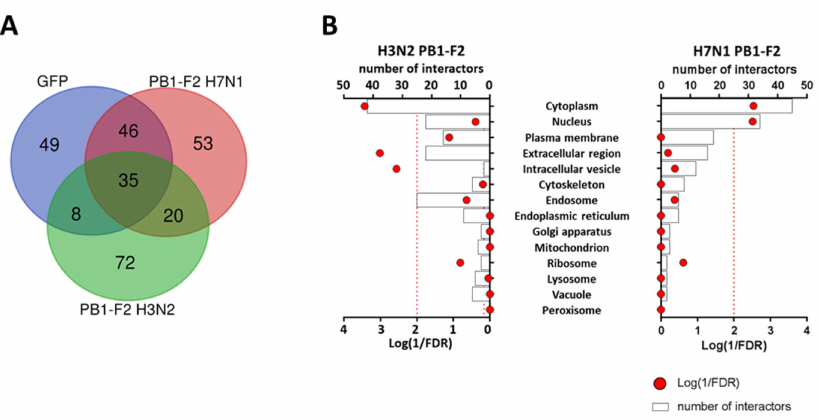
Figure 3. ( A ) Venn diagram representing the repartition of BioID2 fusion proteins interacting partners. ( B ) Details of the compartments targeted by the BioID2 PB1-F2 fusion proteins according to the cellular location of their binding